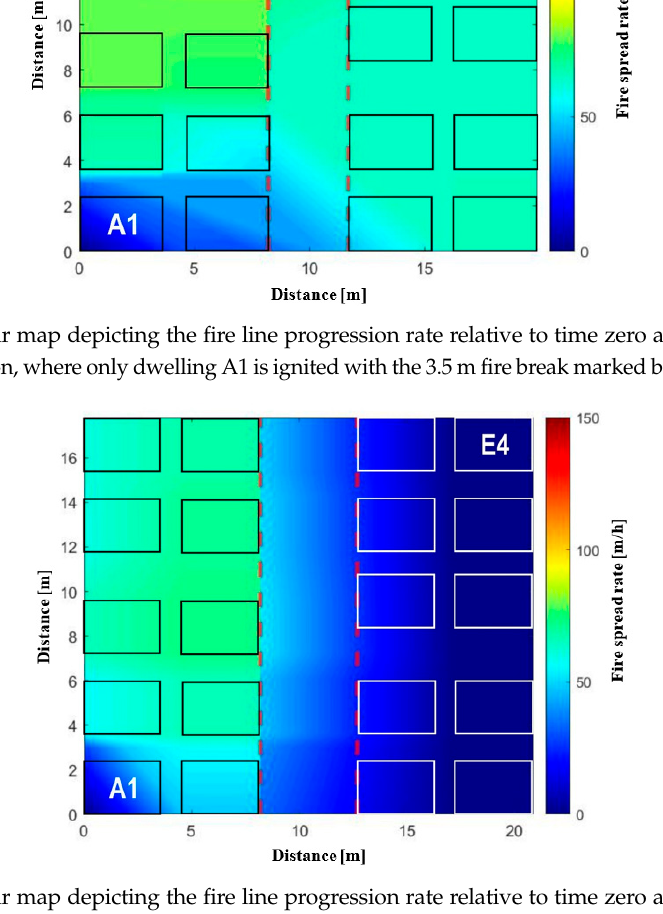
Figure 15. Colour map depicting the fire line progression rate relative to time zero and pattern of the baseline simulation, where only dwelling A1 is ignited with the 4.5 m fire break marked by dotted red lines.